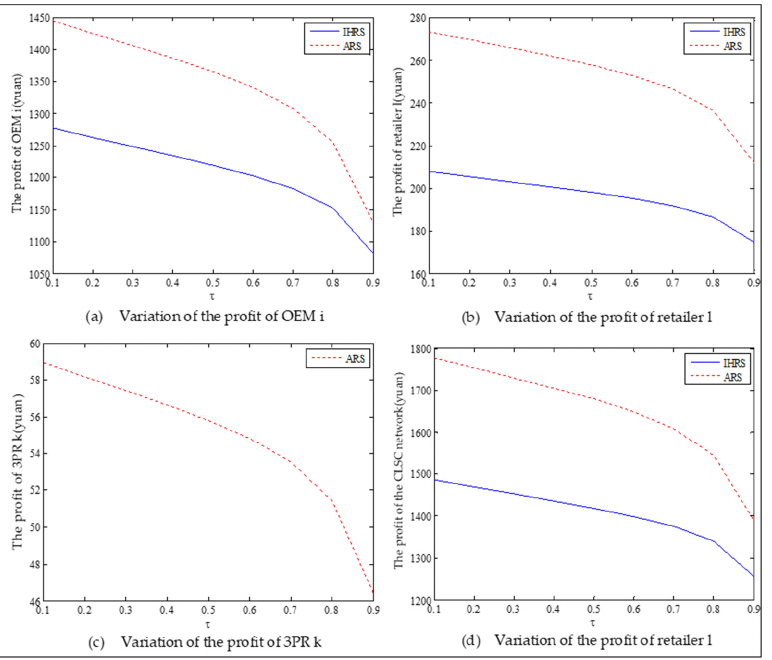
Figure 24. The variation of the profits in Case 2 of Section 6.3.